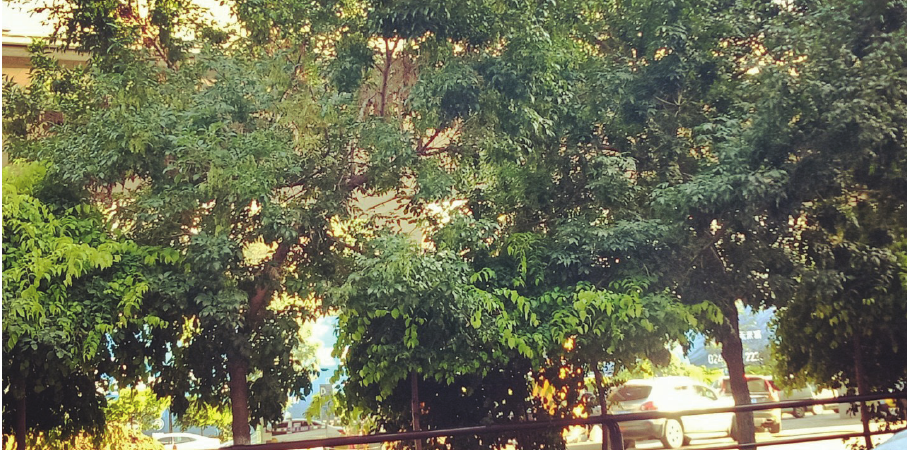
Figure 26. One habitat of Bicurta hejunhuai sp. nov.: greening trees Fraxinus pennsylvanica in the street of Downtown Shenyang City, Liaoning province, China (cell phone photo by Jia-He